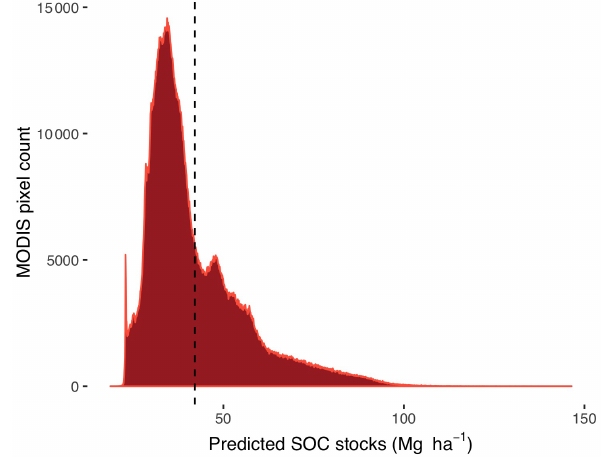
Figure 1. The distribution of SOC stocks to 30cm depth in Kenya. The vertical dashed line shows the mean (42Mgha − 1 ) for the coun-